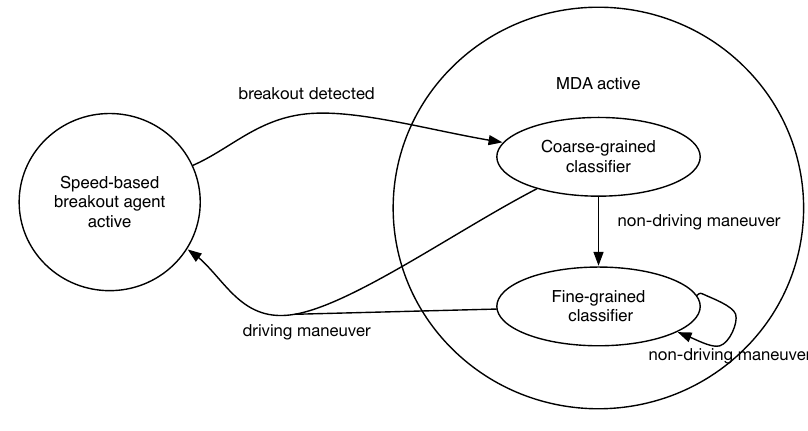
Figure 3. Orchestration of agents and